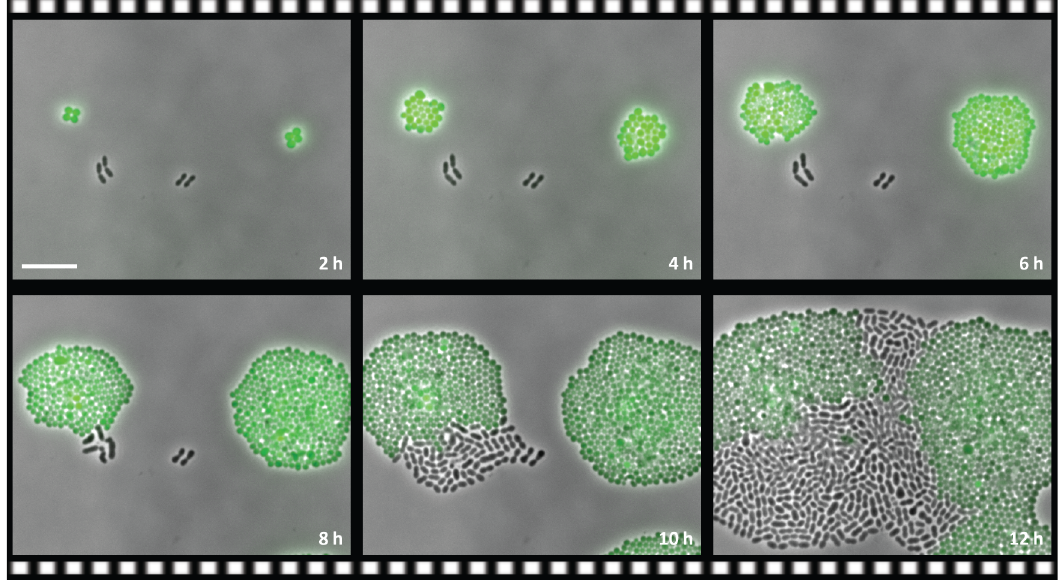
Fig 1. Antibiotic resistance in a microbial community. Still images of a time-lapse experiment show that the green- labeleddrug-resistant strain of Staphylococcus aureus provides resistancefor the non-labeled drug-sensitive strain of Streptococcus pneumoniae duringantibiotictreatment. Image credit: doi: 10.1371/journal.pbio.2000631.